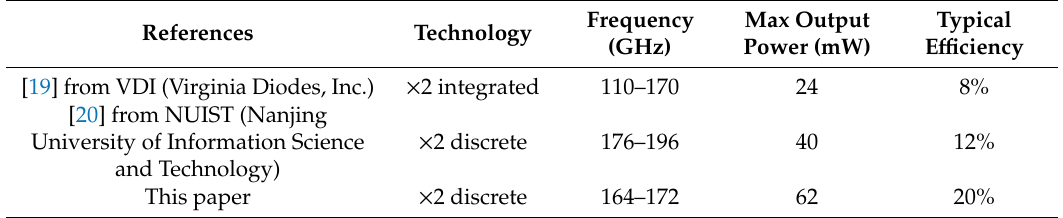
Table 1. Performance comparison of the doubler around 170 GHz.